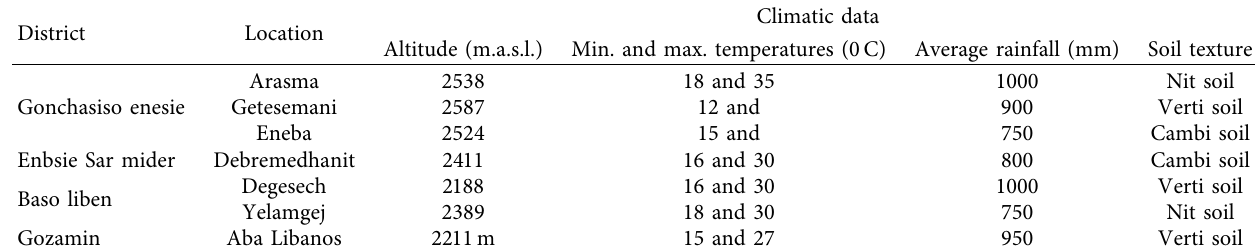
Table 1: Climatic conditions and soil texture of testing locations.